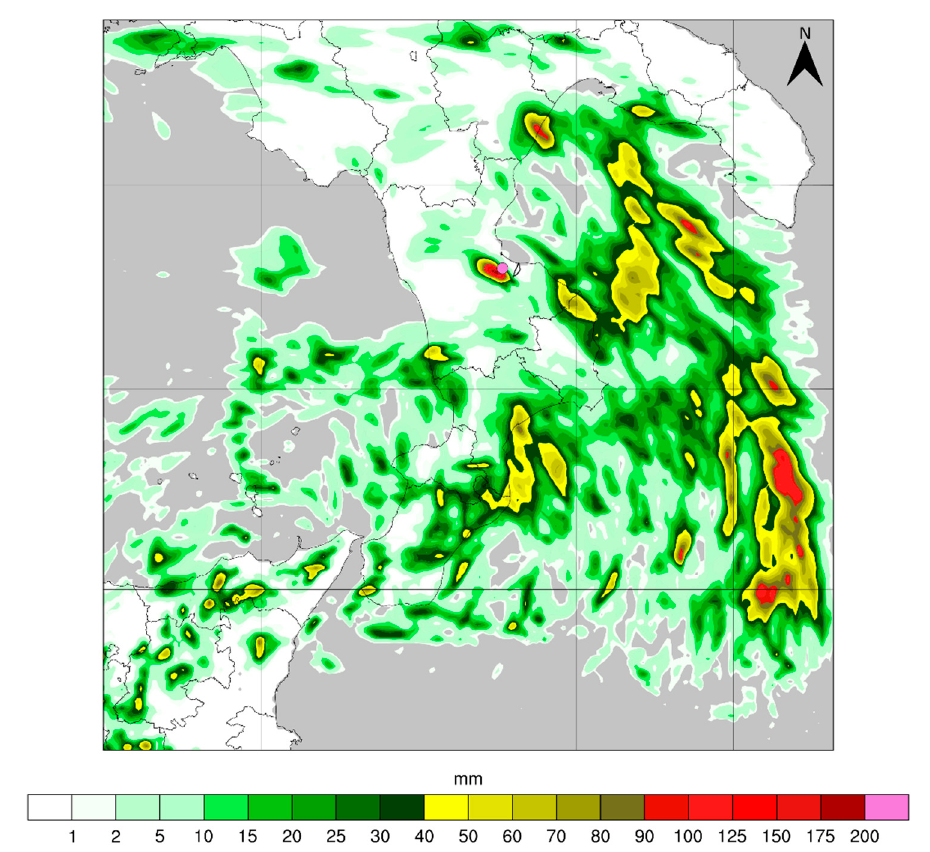
Figure 7. 24-h accumulated precipitation (mm) simulated by WRF using the boundary conditions from the ECMWF EPS perturbed forecast no. 36 (from 1800 UTC, 11 August 2015 to 1800 UTC, 12 August 2015; starting time of the forecast 0000 UTC, 11 August 2015). The colored dot highlights the Corigliano’s rain gauge station. The borders of the Citrea creek catchment are also represented.